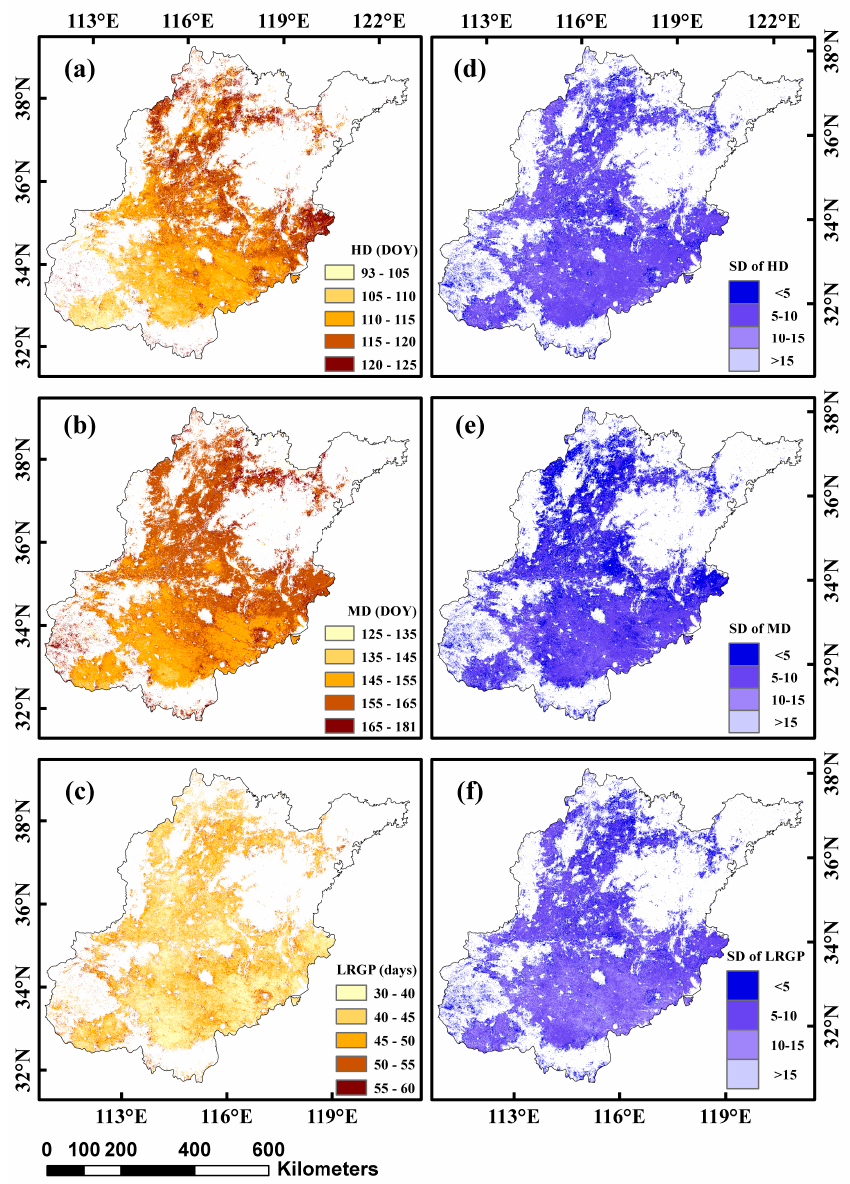
Figure 4. The spatial distributions of the heading date (HD) ( a ), maturity date (MD) ( b ), and length of the reproductive growth period (LRGP) ( c ), as well as their standard deviations ( d – f ), across the NCP, averaged from the harvest years